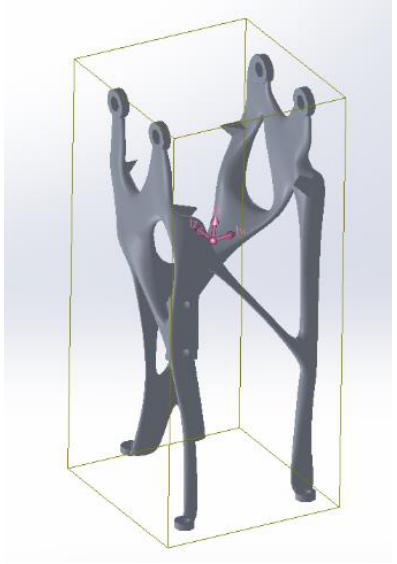
Figure 10. A357 component for Selective Laser Melting (SLM).